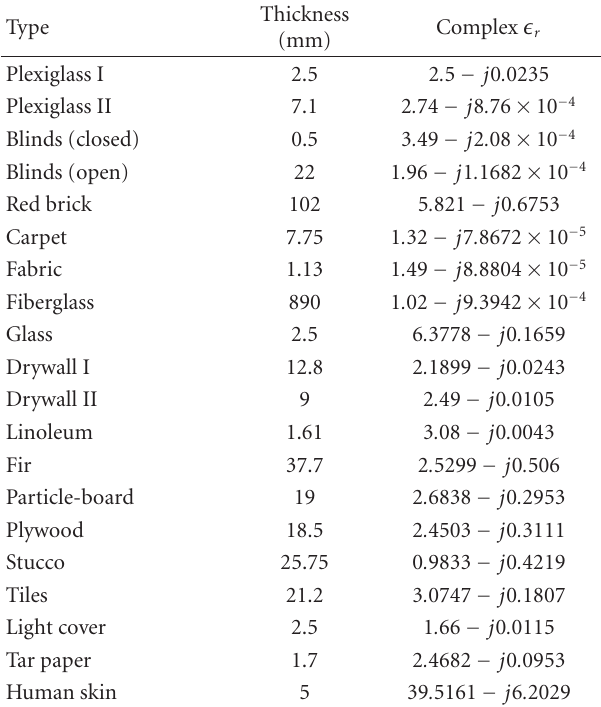
Table 2: Measured permittivity of indoor materials at 2.4